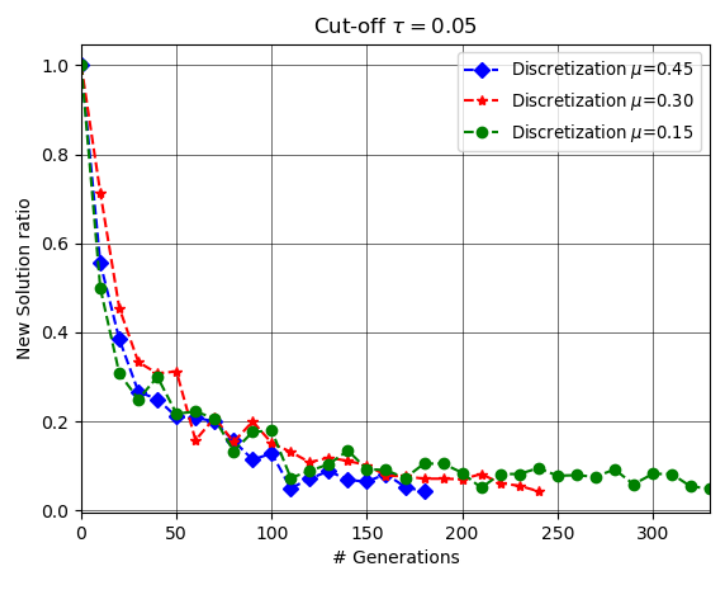
Figure 6. Ratio of new solutions. Table 5. Number of generations achieved for cut-off τ = 0.05 for each µ .